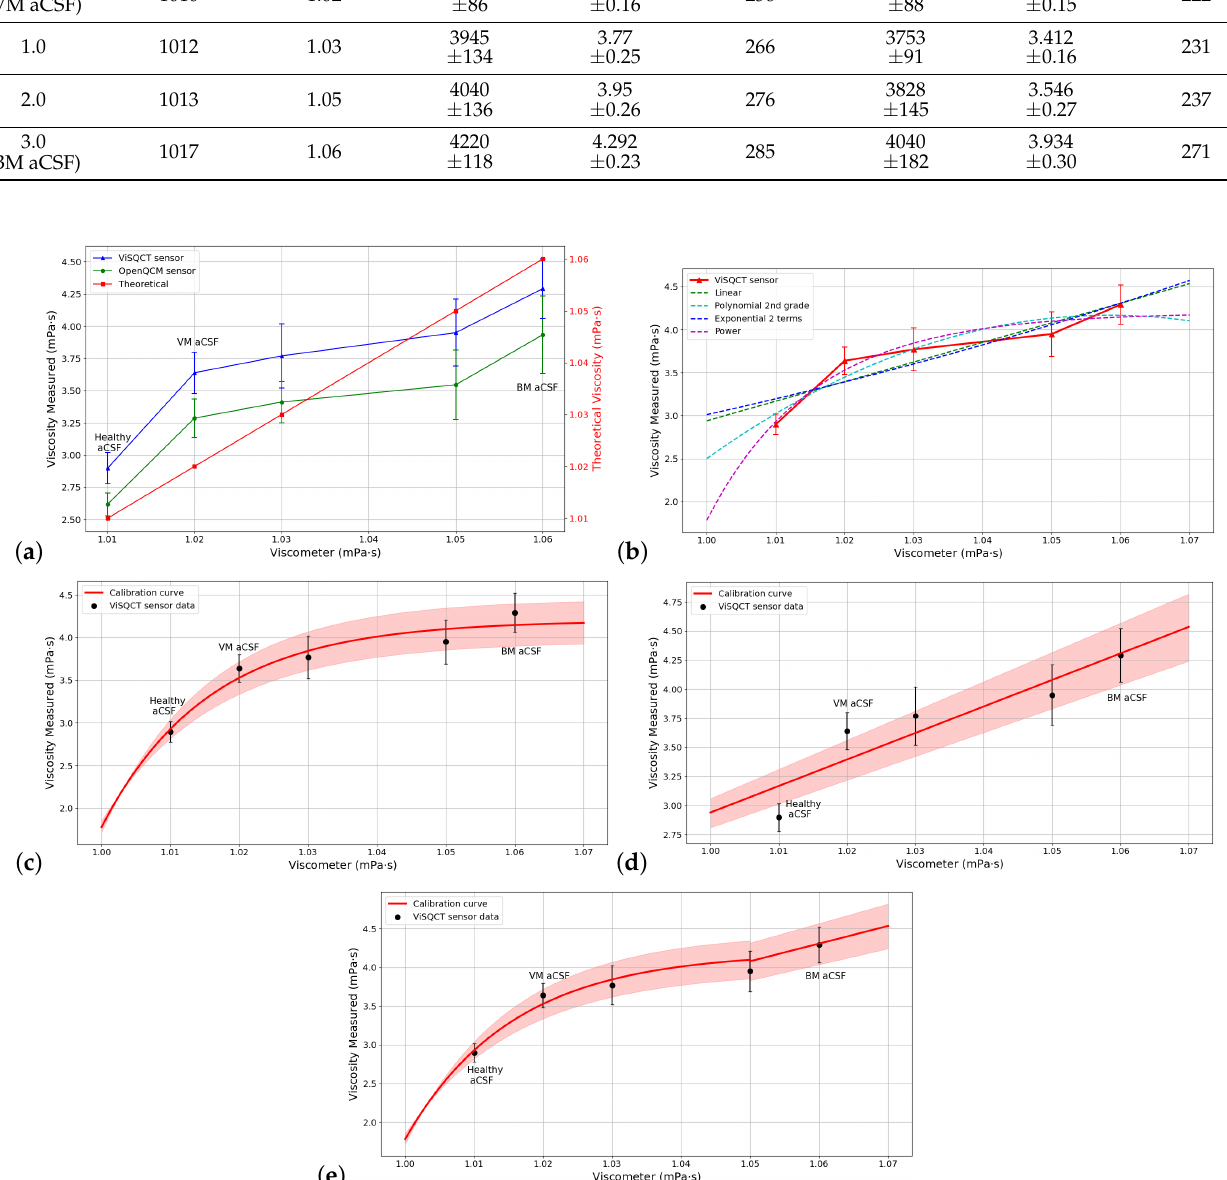
for aCSF; also, the RMSE of the fit is noted. In Figure 7b, all the curves are shown. The curve with the lowest error is the Power function curve having an RMSE of 0.176, which is marked in the